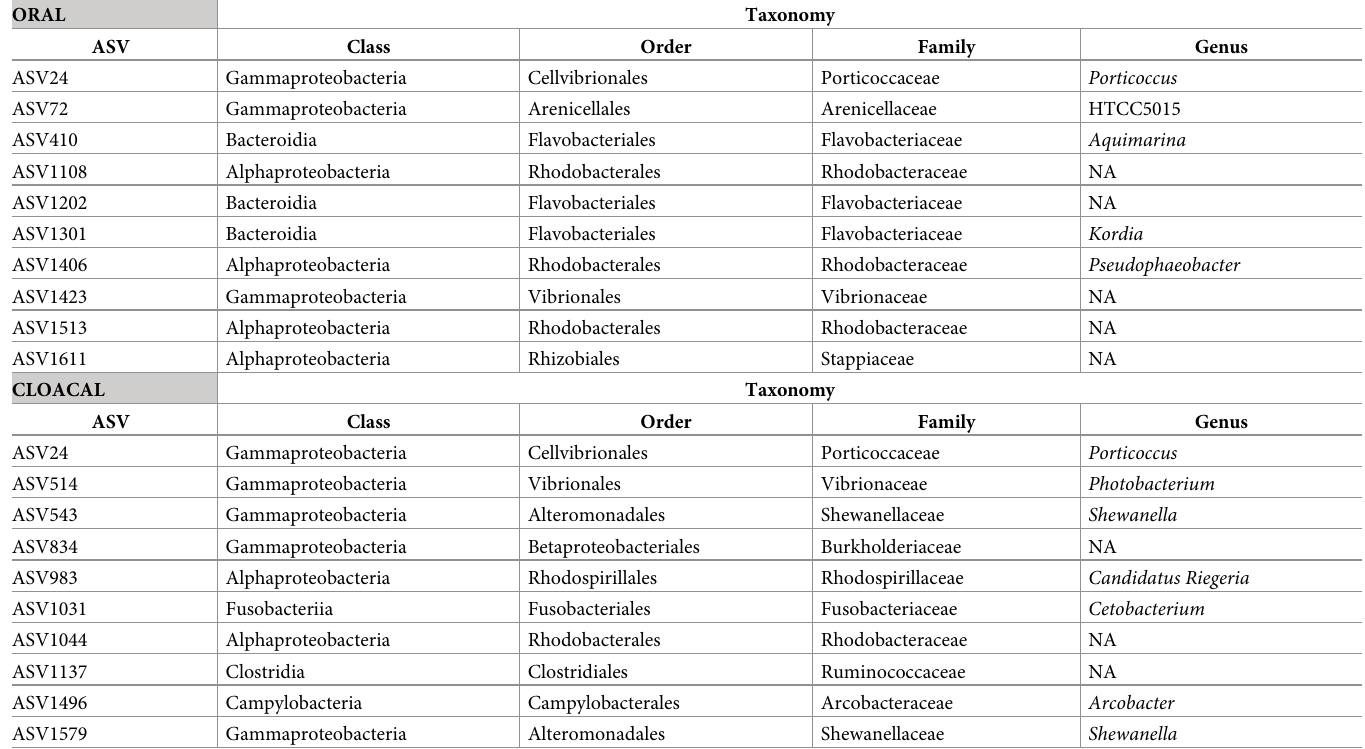
Table 1. Taxonomy of the top 10 ASVs predicting survival. Survival was predicted by random forest modelling for both oral and cloacal samples at intake.